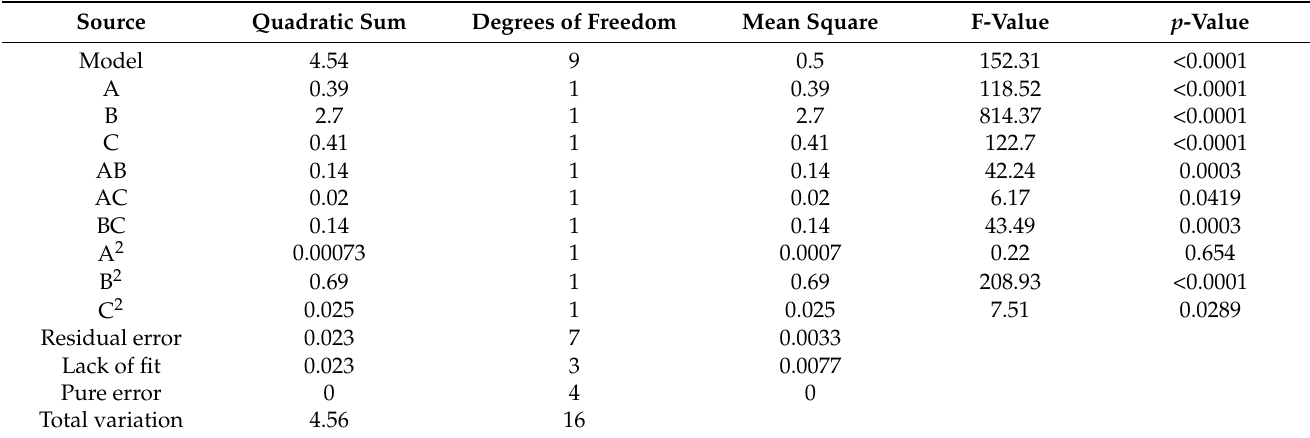
Table 3. Analysis of the variance of T max .